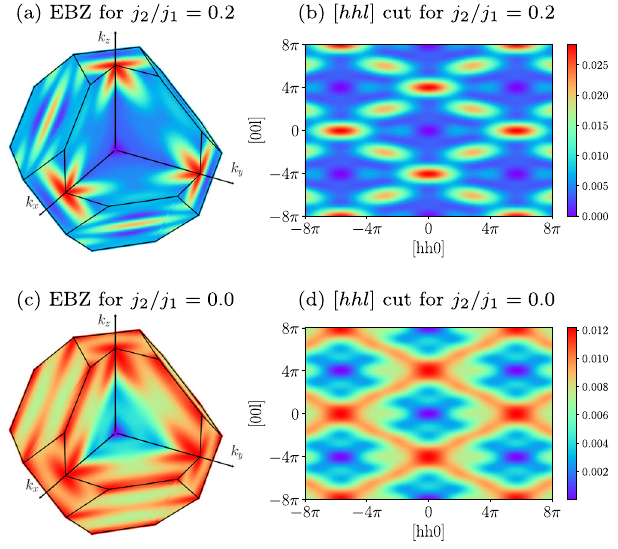
FIG. 8. (a) Momentum-resolvedcorrelationsonthethree-dimen- sional extended Brillouin zone obtained within ED on a 4 × 2 3 cluster with λ ¼ 1 , j 2 =j 1 ¼ 0 . 2 . (b) The ½ hhl (cid:4) plane slice of the extended Brillouin zone. (c,d) Same measurements at j 2 =j 1 ¼ 0